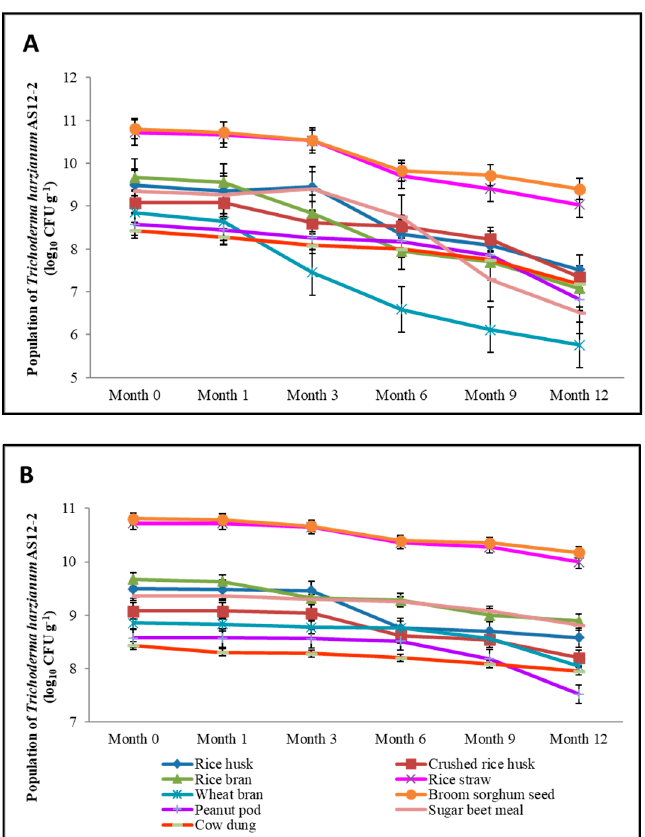
Figure 2. Viability of Trichoderma harzianum AS12-2 in nine organic substrates under solid-state fermentation after different incubation periods (1–12 months) at ( A ) room temperature (25 ± 2 °C) and ( B ) in the refrigerator (4 °C). Bars represent the standard error of the mean.